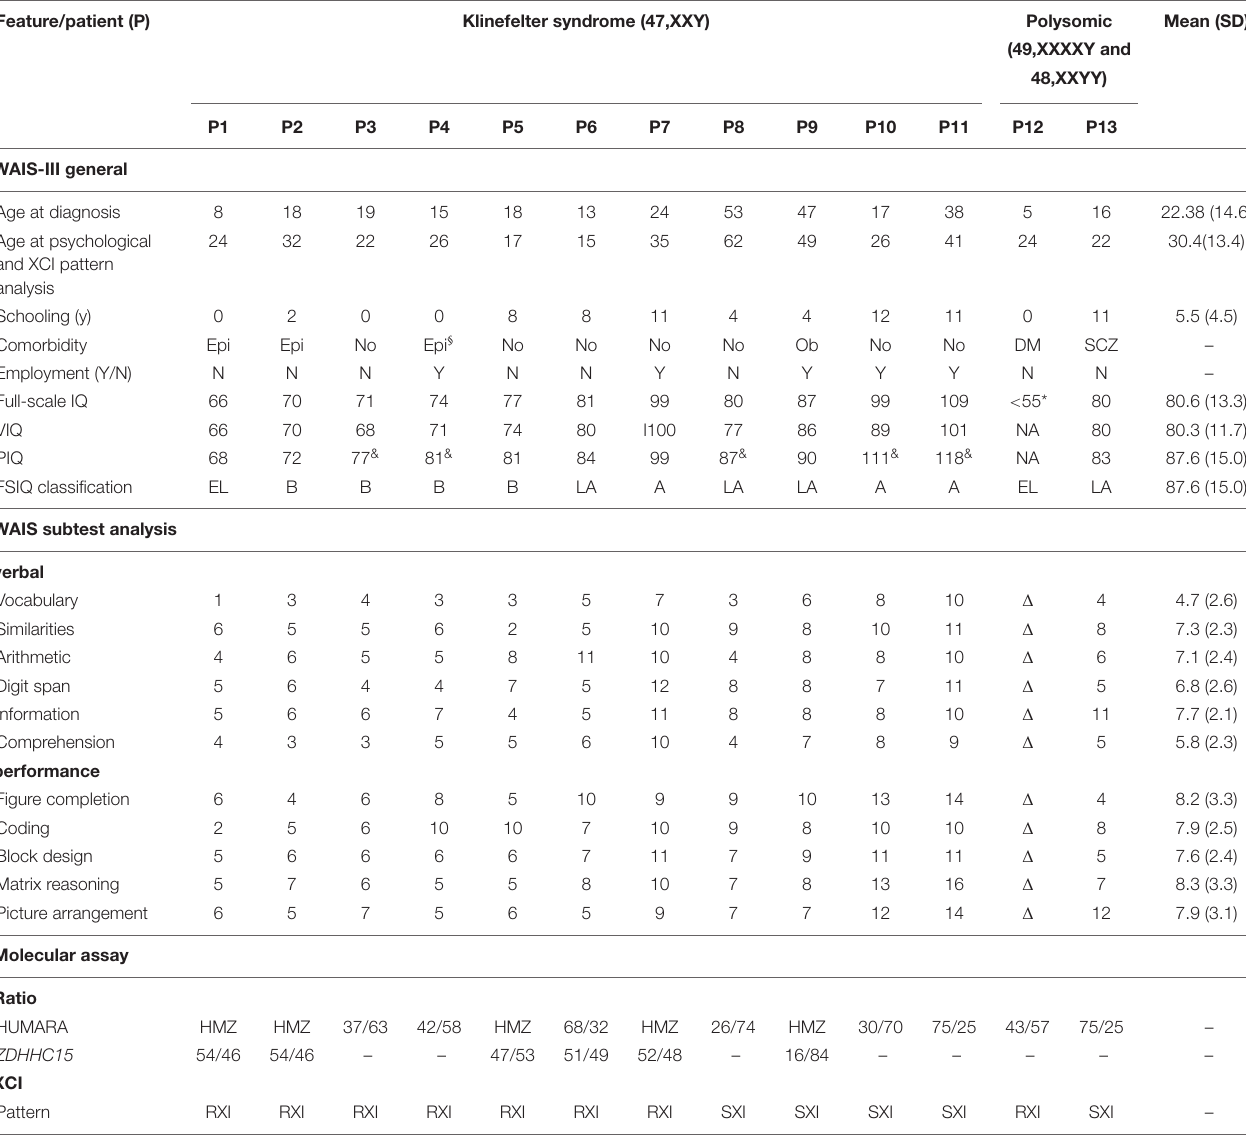
TABLE 1 | Sociodemographic, clinical, and neuropsychological characterization and X-chromosome inactivation features observed in Klinefelter syndrome. Feature/patient